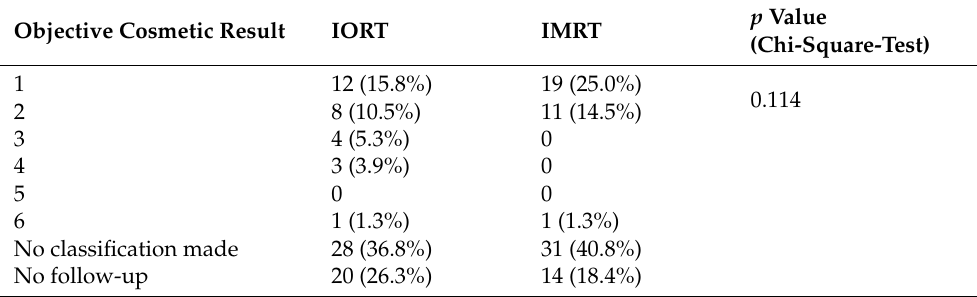
Table 7. Objective cosmetic result evaluated during follow-up, assessment of the physician providing treatment, scale equal to school grades (1: very good, 6: